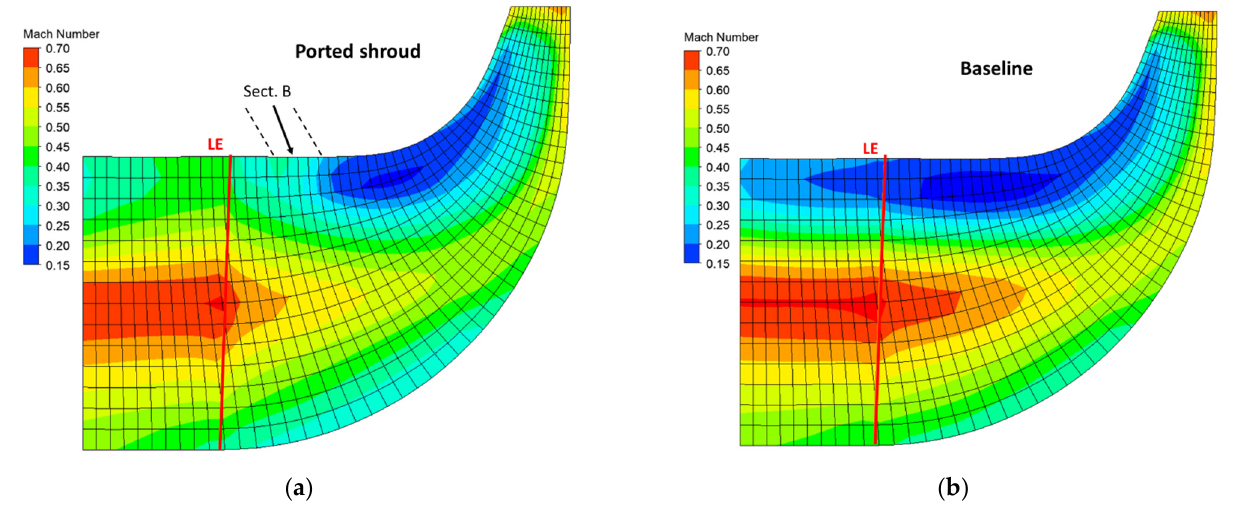
Figure 13. Contour of the relative Mach number in the meridional plane at near surge condition OP2—configurations with ported shroud ( a ) and baseline ( b ).